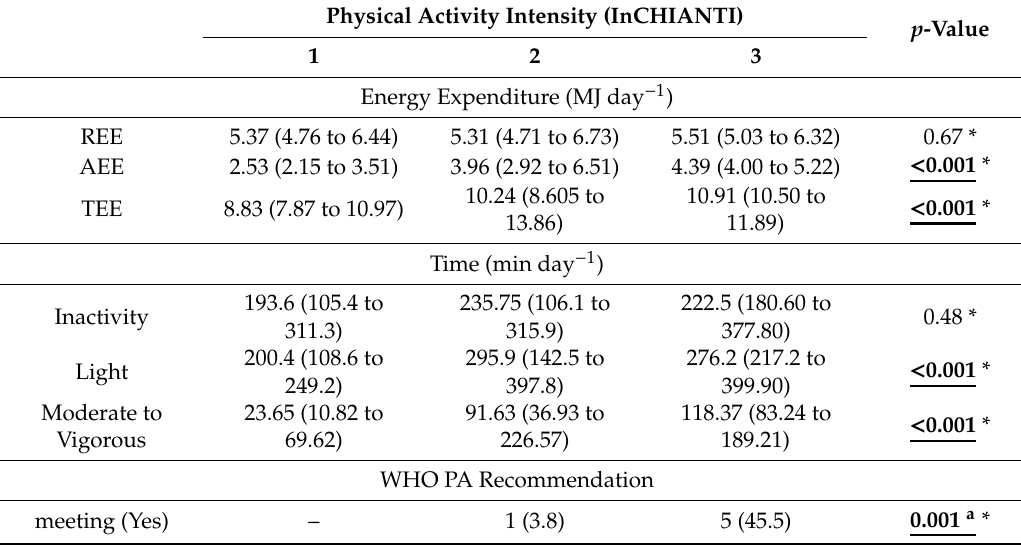
Table 3. Descriptive statistics of accelerometer-based PA variables in the InCHIANTI